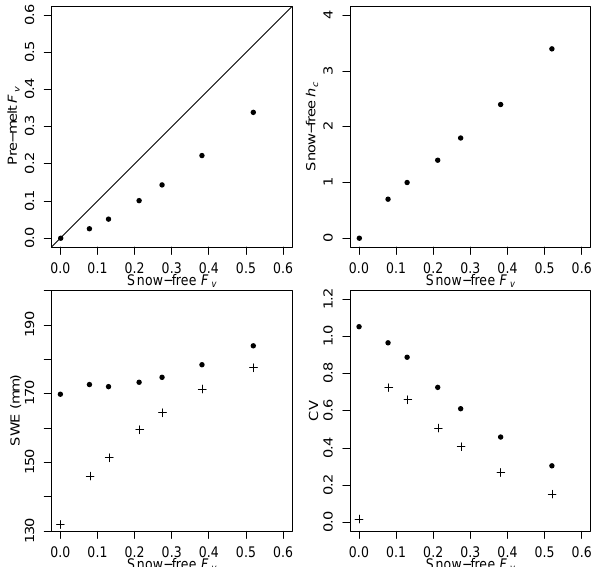
Figure 10. Exposed vegetation fraction, vegetation height, mean SWE and coefficient of variation in SWE on 22 April as functions of snow-free vegetation fraction for simulations with (dots) topog- raphy and without